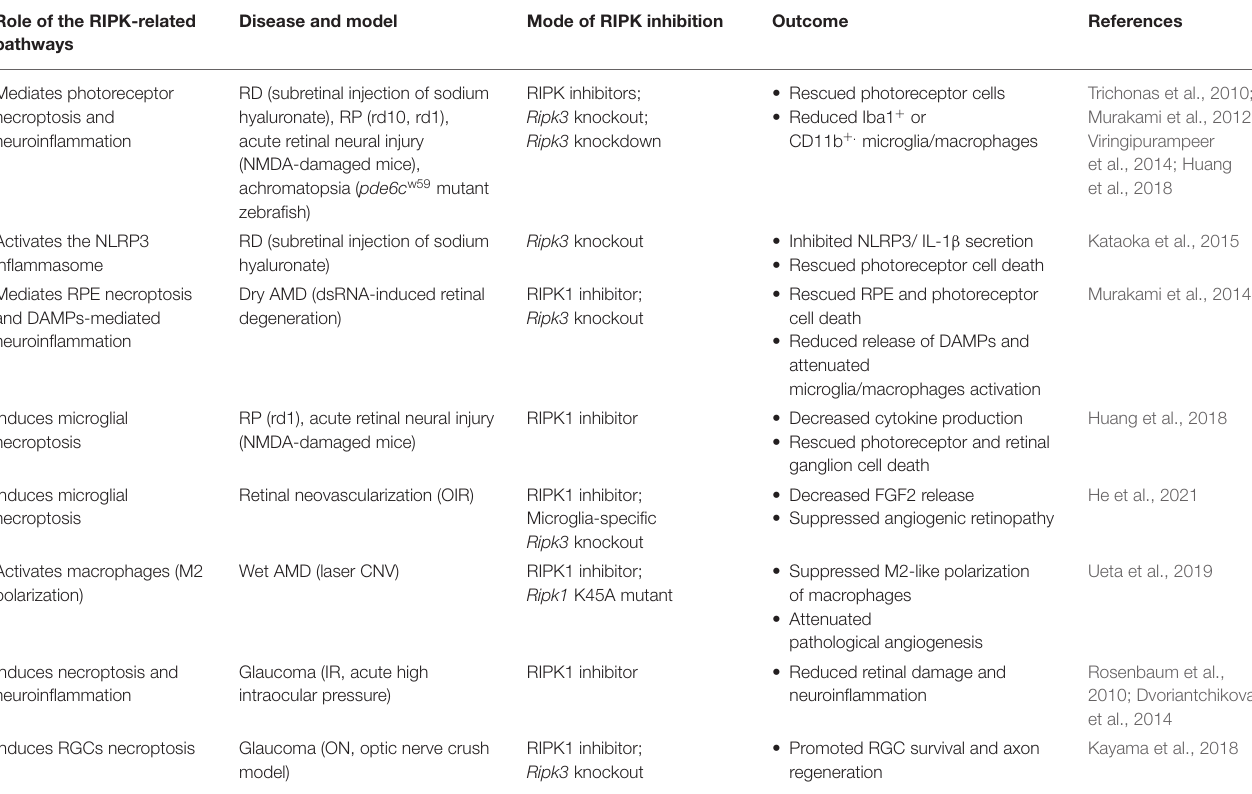
TABLE 2 | Pharmacological and genetic interventions that manage cell death and inflammation in RIPK-related pathways in retinal